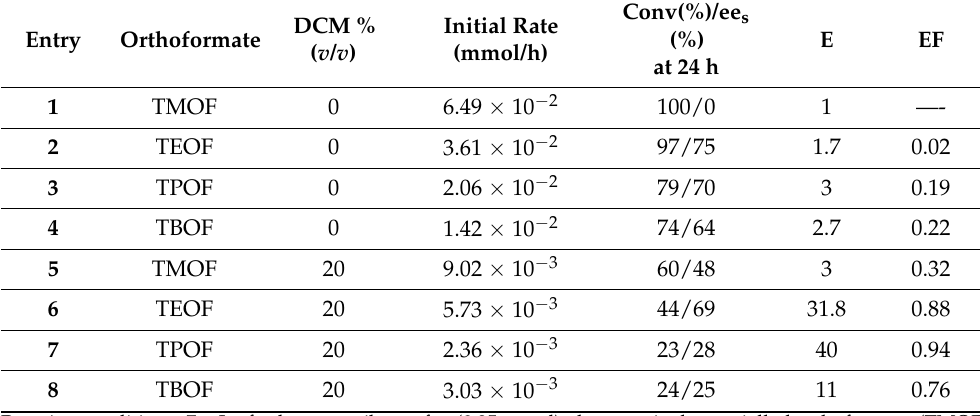
Reaction conditions: 7 mL of solvent, rac -ibuprofen (0.35 mmol), three equivalents trialkyl orthofor- mate (TMOF, TEOF, TPOF or TBOF), 0.5 eq. of alcohol (methanol, ethanol, n -propanol or n -butanol), 0.0721 g of immobilized lipase, T = 40 °C, orbital shaking at 250 rpm (see section 3.3.3).